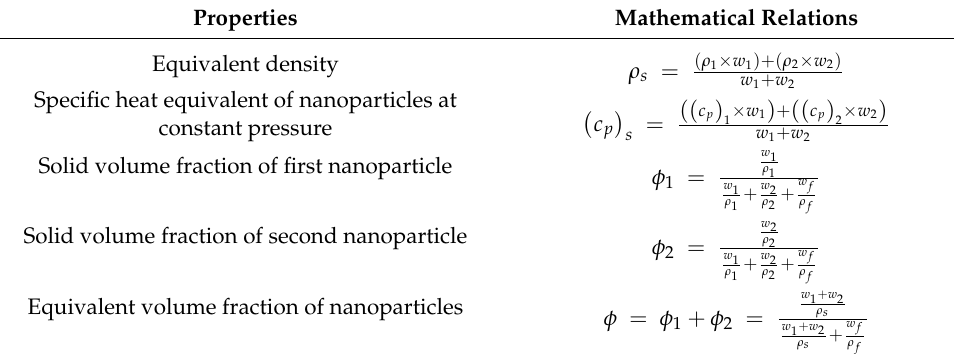
Table 3. The mass-based models for selective hybrid nanofluids [23,24,53]. Properties